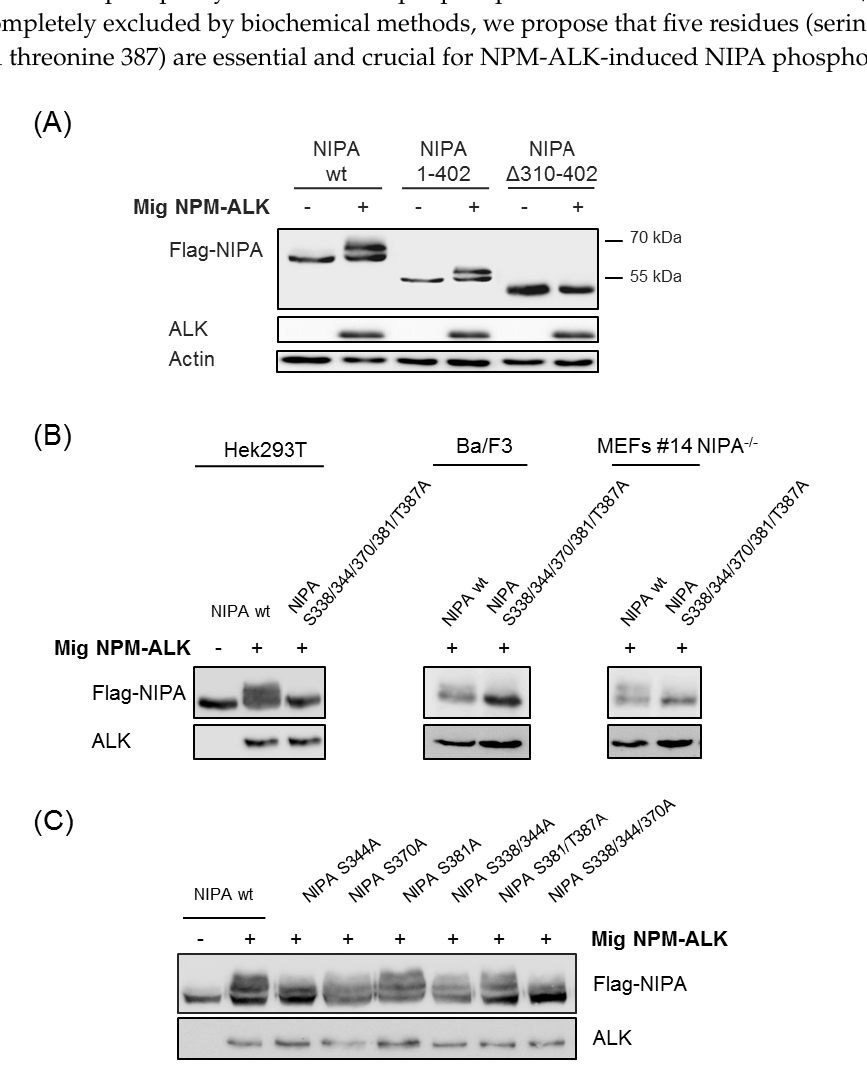
Figure 3. NPM-ALK induces phosphorylation of NIPA at Ser-338, Ser-344, Ser-370, Ser-381 and Thr-381. ( A ) Hek293T cells were transiently transfected with pCDNA Flag hNIPA wt, pCDNA Flag hNIPA 1-402, pCDNA Flag hNIPA ∆ 310-402 +/ − Mig NPM-ALK and subjected to western blot. Immunoblotting confirmed that region 310–402 seems to be crucial for NPM-ALK mediated NIPA phosphorylation. ( B , C ) Hek293T cells were transiently transfected with pCDNA Flag hNIPA wt, pCDNA Flag hNIPA S344A, pCDNA Flag hNIPA S370A, pCDNA Flag hNIPA S381A, pCDNA Flag